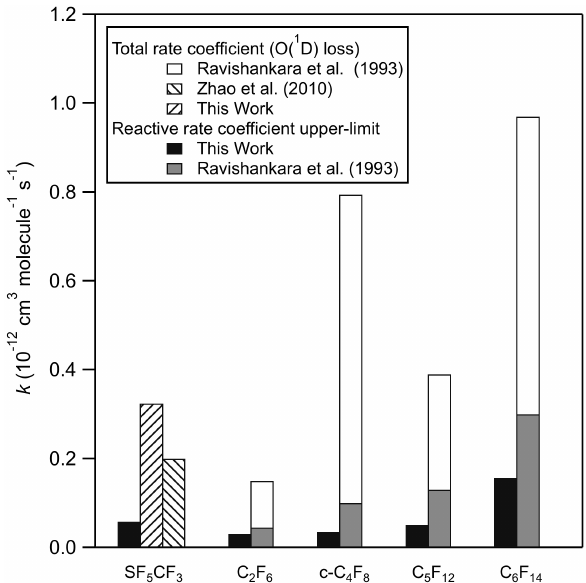
Fig. 6. Summary of the total and reactive rate coefficient data for the reaction of O( 1 D) with SF 5 CF 3 , C 2 F 6 , c-C 4 F 8 , C 5 F 12 , and C 6 F 14 obtained in this work and reported in the literature (see